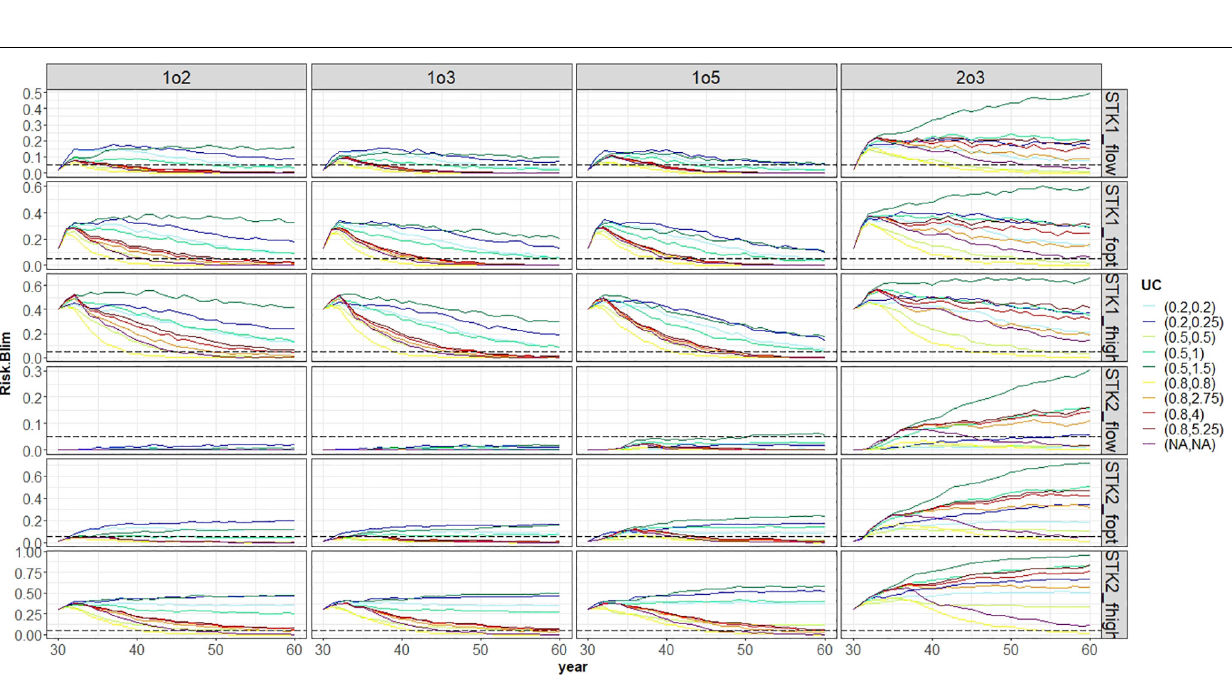
Frontiers in Marine Science |